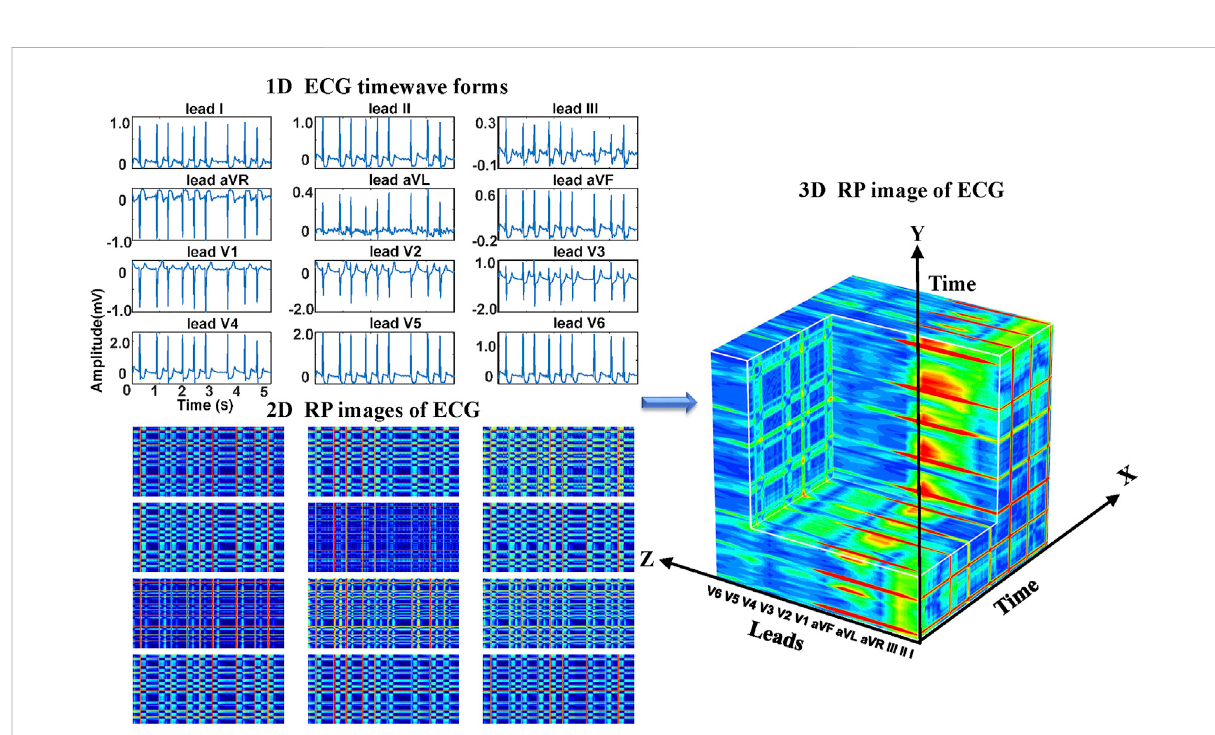
FIGURE 4 The 3DRP image reconstructed based on